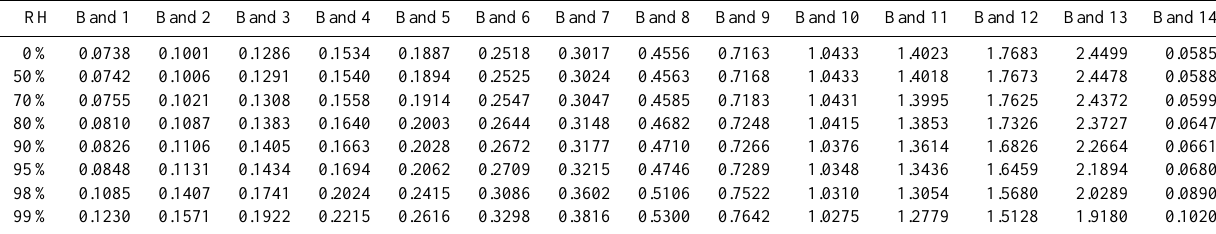
Table A1. AOD spectral scale factor ρ rj for the rural aerosol mixture.